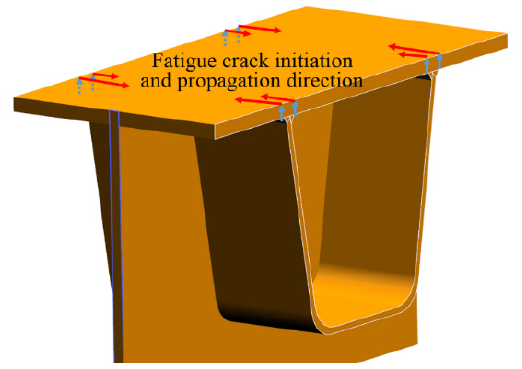
Figure 8. Hypothetical fatigue crack initiation and propagation on the bridge deck.